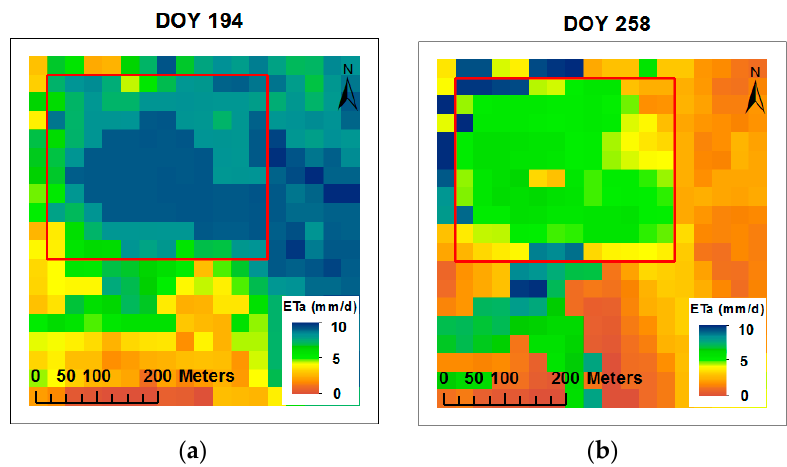
Figure 12. Actual evapotranspiration (ETa) maps developed by the METRIC model for mid-season (( a ) DOY 194) and late season (( b ) DOY 258) during the 2016 corn growing season. The red rectangle indicates the area of interest within the corn field. Table 5. ETa values estimated by the METRIC model for five observation locations and six overpass dates during season.